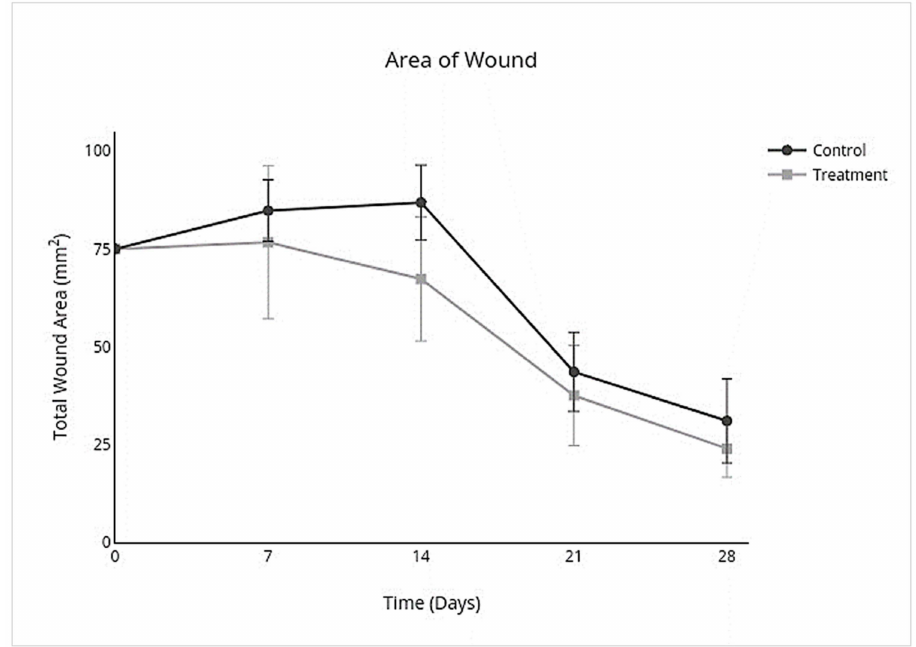
Figure 4. Total area (mm 2 ) of limb wounds. There was an overall decrease in total nonhaired wound area over all days but no treatment effect on individual days. Both treatment and control wounds had an increase in nonhaired wound area during the lag phase but were less pronounced in the treatment